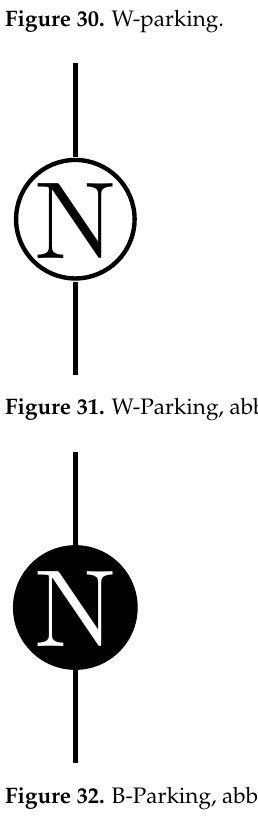
Figure 30. W-parking.